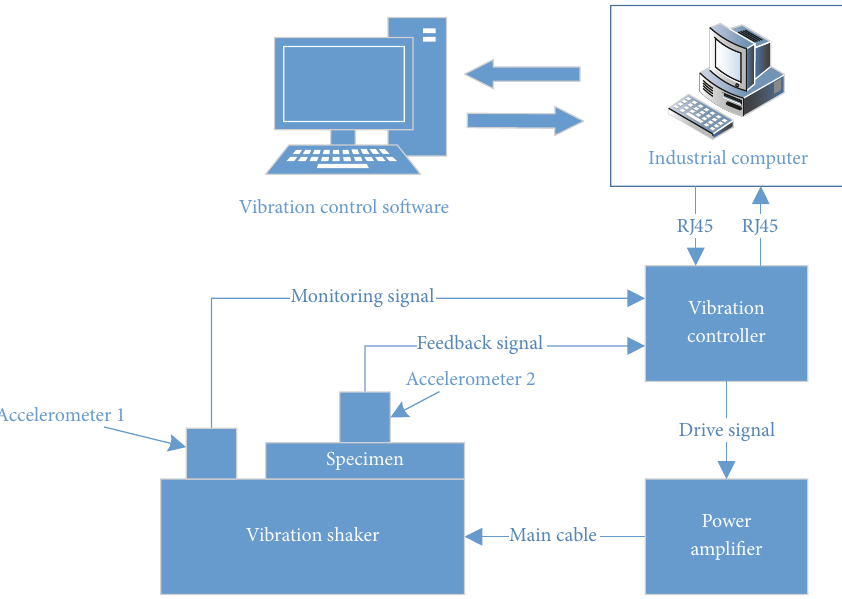
Figure 3: The schematic diagram of the vibration fatigue test system.